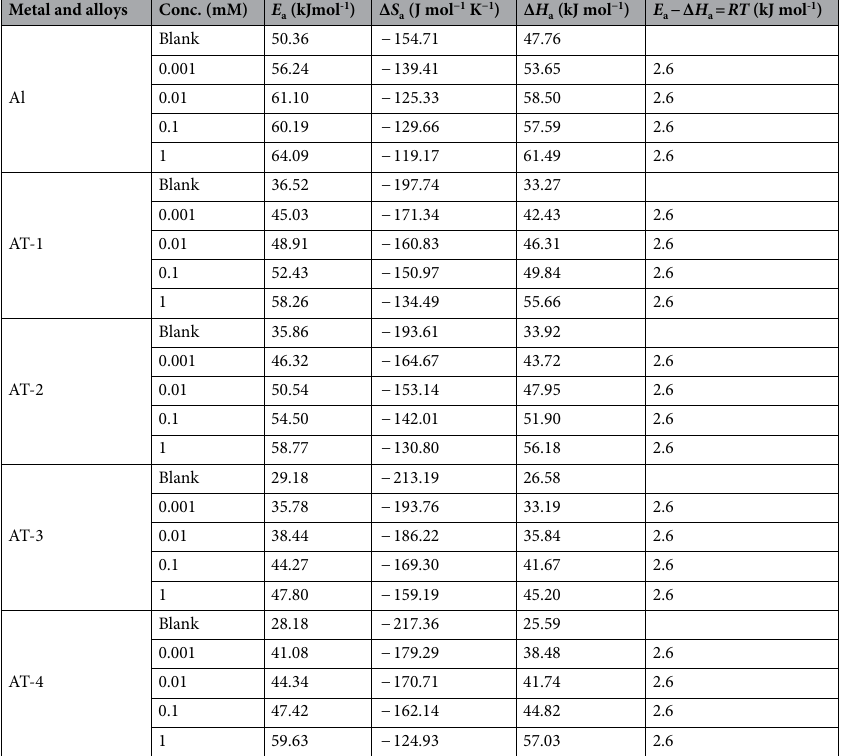
Table 4. Activation thermodynamic parameters for Al and Al–Ti alloys in (0.5 M) HCl solution comprising different concentrations of 2-MBT inhibitor after 30 min of exposure.